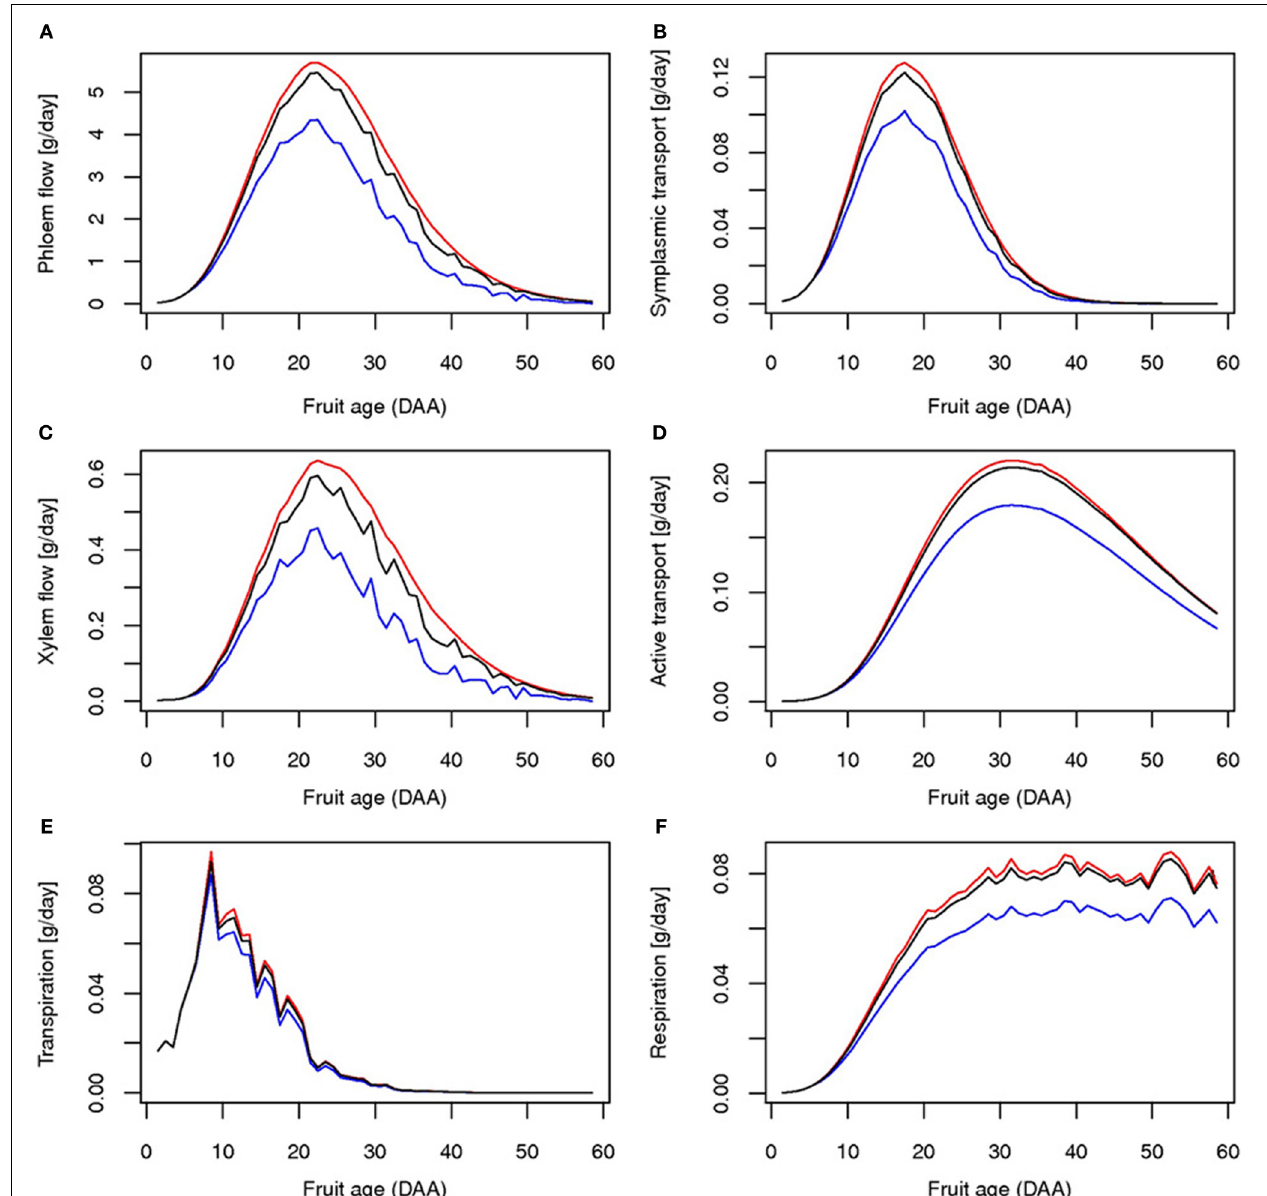
FIGURE 7 | Simulated daily fluxes (g/h) at the fruit level for truss rank 4 for control (black line), water deficit (blue line), and carbon limitation (red line): phloem flow (A), xylem flow (B), transpiration (C), symplasmic transport (D), active transport (E) and respiration (F).